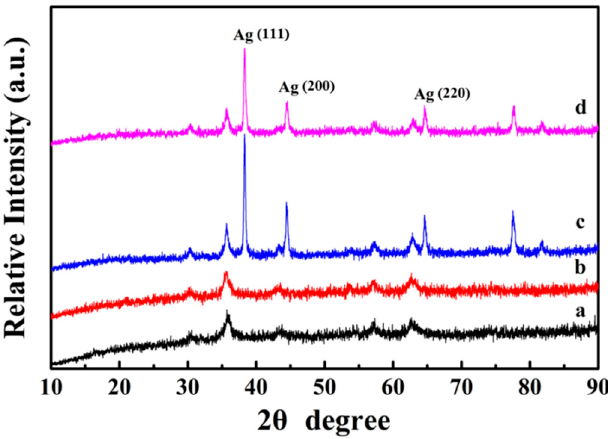
XRD di ff raction patterns of the Fe 3 O 4 ( a ), Fe 3 O 4 @PDA ( b ), Fe 3 O 4 @PDA / Ag ( c ), Figure 4. XRD diffraction patterns of the Fe 3 O 4 ( a ), Fe 3 O 4 @PDA ( b ), Fe 3 O 4 @PDA/Ag ( c ), and and Fe 3 O 4 @PDA / Ag / PDA ( d ) Fe 3 O 4 @PDA/Ag/PDA ( d ) nanospheres.